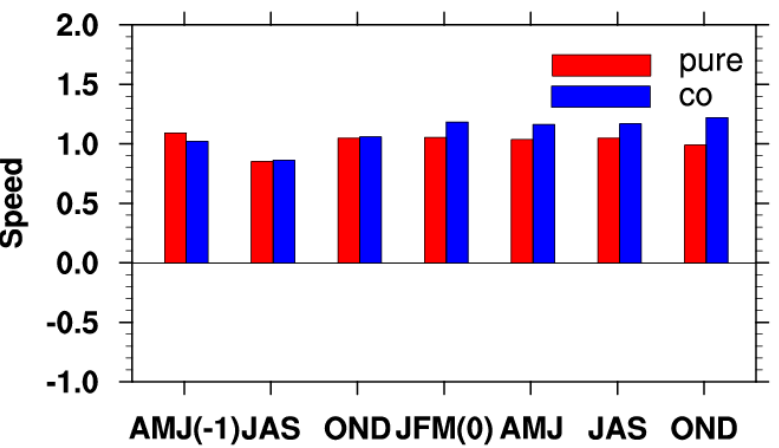
Figure 14. Histograms of the seasonal mean for wind strength produced by the pure IOD events and pIOD events that occurred with El Niño. Red bars represent the pure IOD events; blue bars represent the pIOD events that occurred with El Niño.